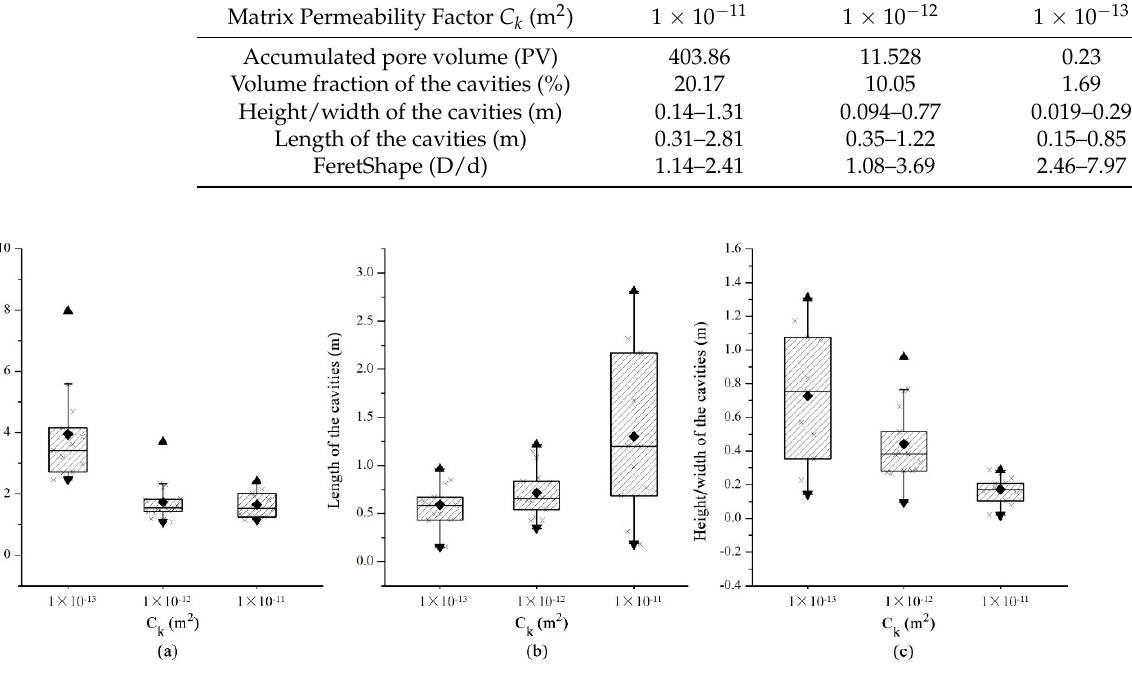
Figure 14. Comparison of the characteristic parameters of the pore shape for different matrix permeabilities. ( a ), ( b ), and ( c ) represent the statistical results of FeretShape, length of cavities, height/width of cavities with different C K ,